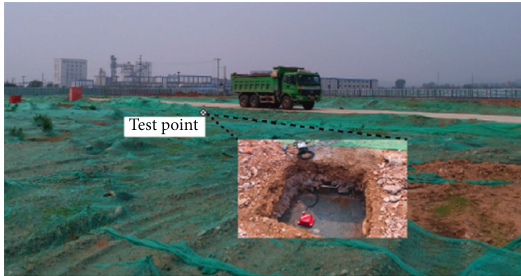
Figure 6: Measurement of the vibration source